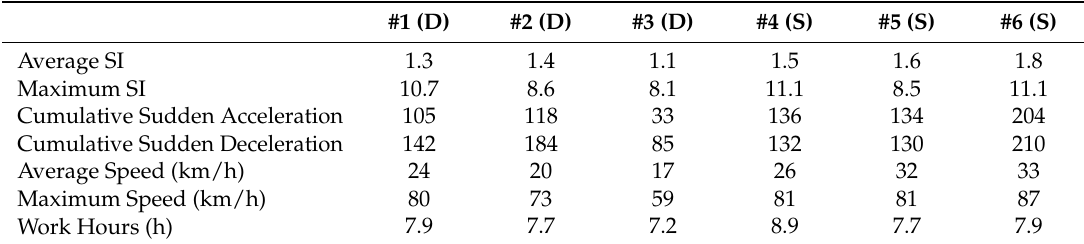
Table 12. Comparison of SI values and components of the dynamic and workload factors for six postal motorcyclists working in Gangseo on 11 November 2015. In the first column of the table, (S) signifies a postman delivering to a suburb of Gangseo and (D) signifies a postman delivering in downtown Gangseo. #1